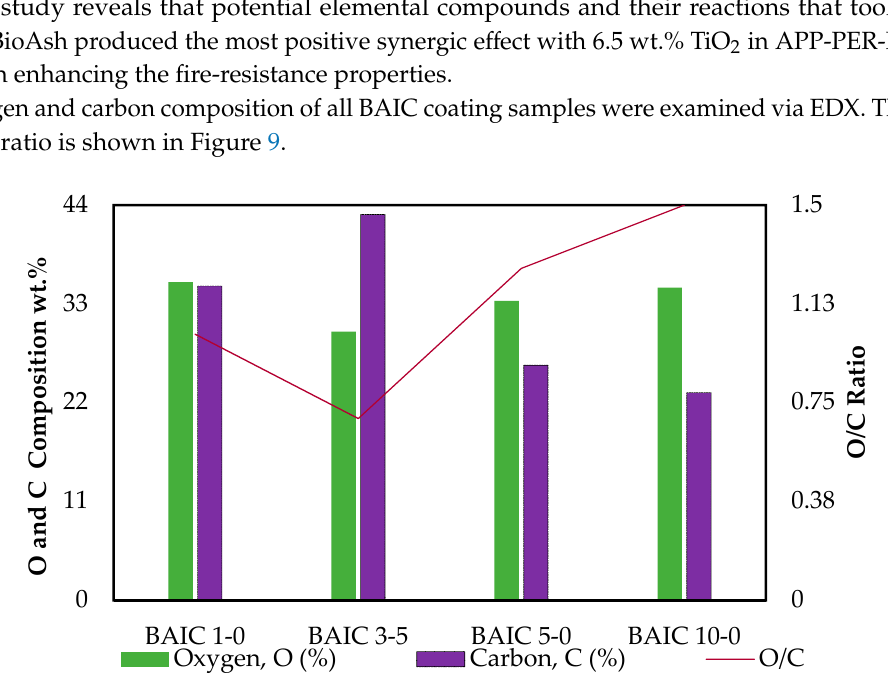
Figure 9. Oxygen and carbon composition, and O / C ratio of BAIC samples.